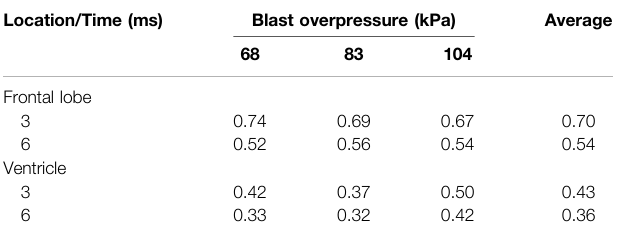
TABLE 3 | Correlation and analysis (CORA) rating between the simulated and experimental pressure-time pro fi les. Location/Time (ms) Blast overpressure